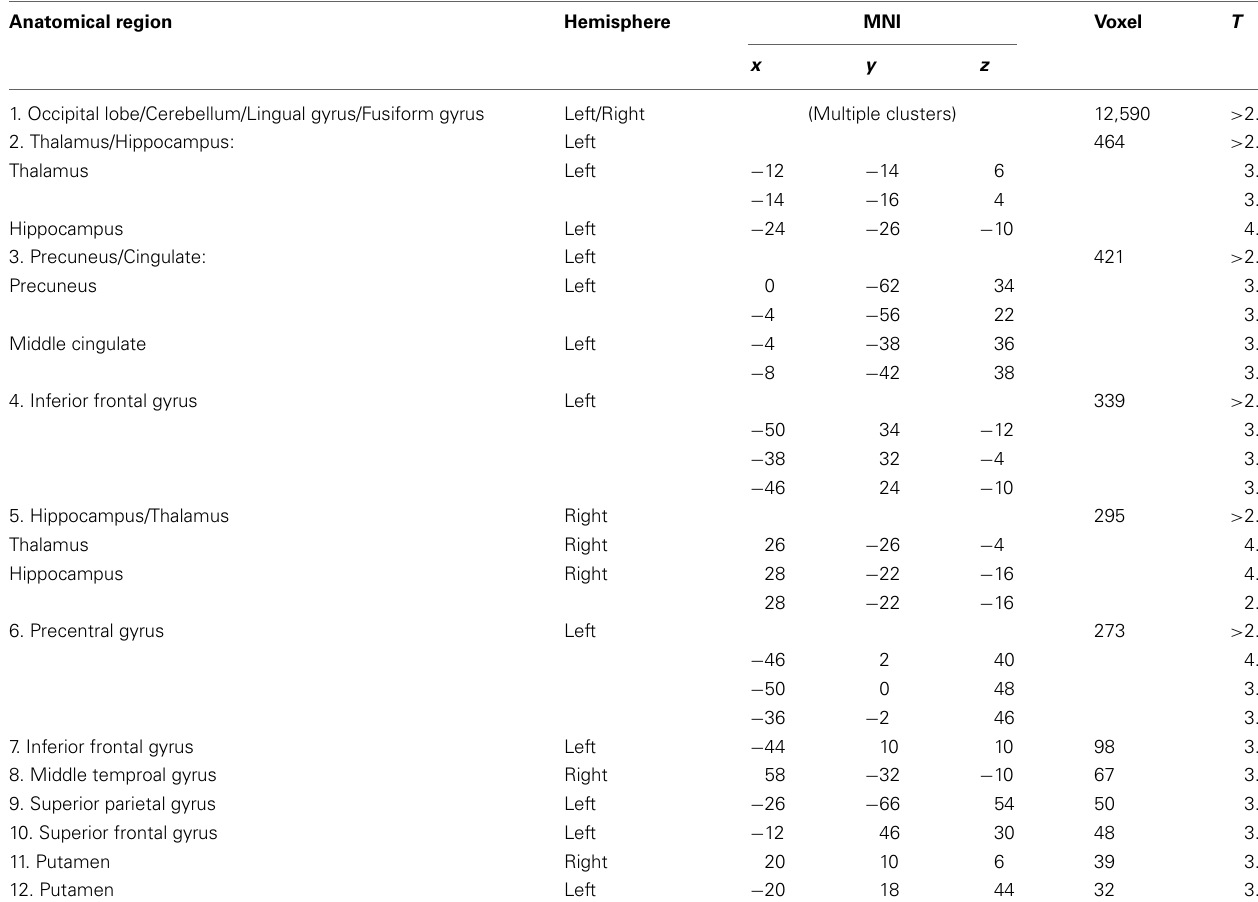
Table 2 | Contrast OPD-sentences > Relaxation at time point